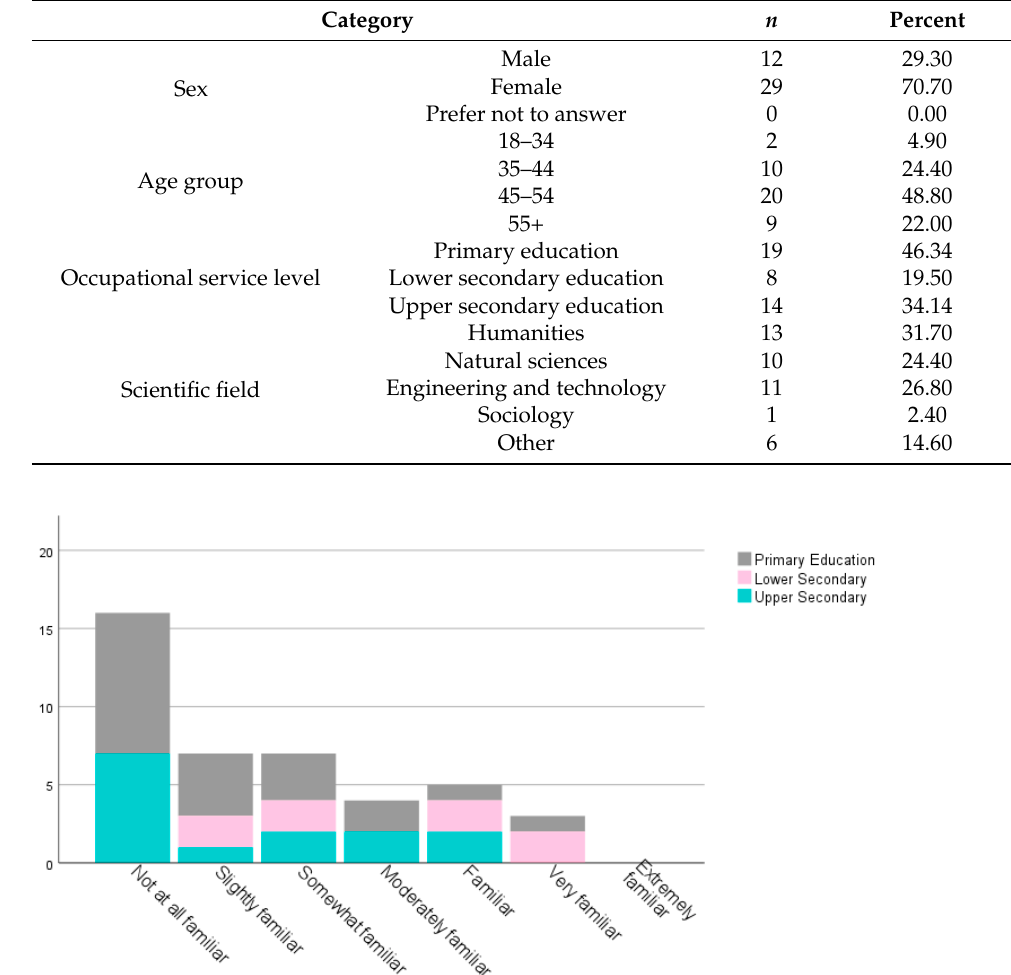
Table 1. Participants’ demographic information.